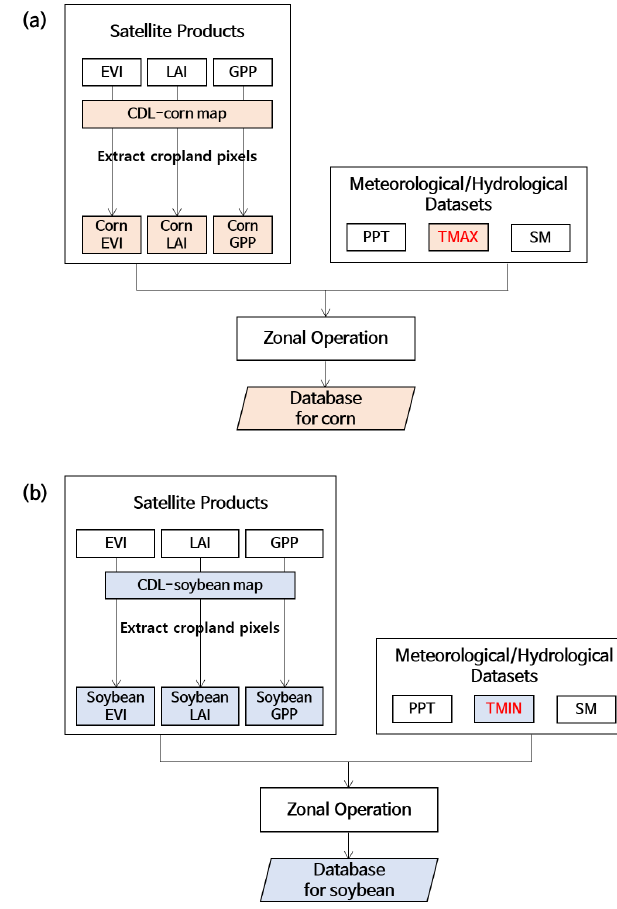
Figure 2. Process for constructing the matchup database for ( a ) corn and ( b ) soybean, based on the Cropland Data Layer (CDL).